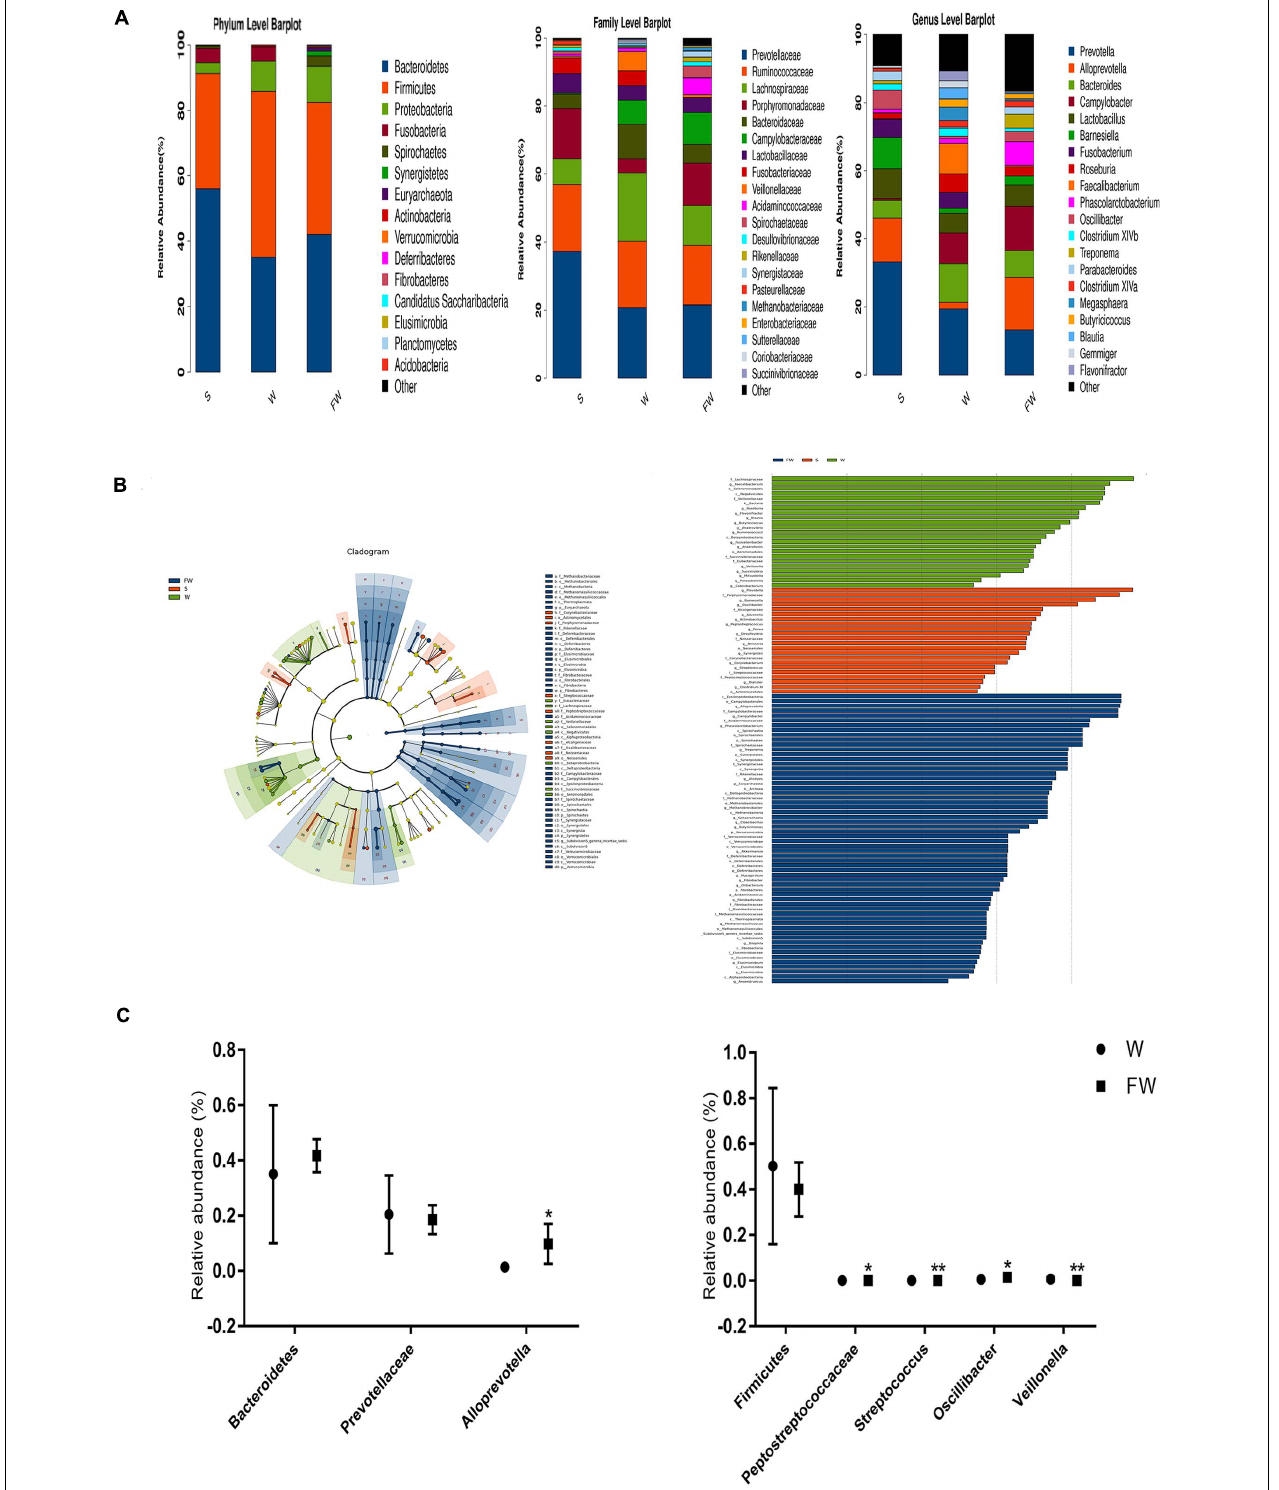
FIGURE 10 | Intestinal microbial community structure of three groups. (A) Relative abundance of microbial community in the colon at phylum, family, and genus level. (B) Cladogram and LDA value distribution histogram based on LEfSe analysis showed significant differences of the microbial community in the three groups. (C) Differences of the relative abundance of Bacteroidetes, Prevotellaceae, Alloprevotella , Firmicutes, Peptostreptococcaceae, Stretococcus , Oscillibacter, and Veillonella between the W and FW group (S, Sucking; W, Weaned; FW, FMT+Weaned). * p < 0.05 and ** p < 0.01.